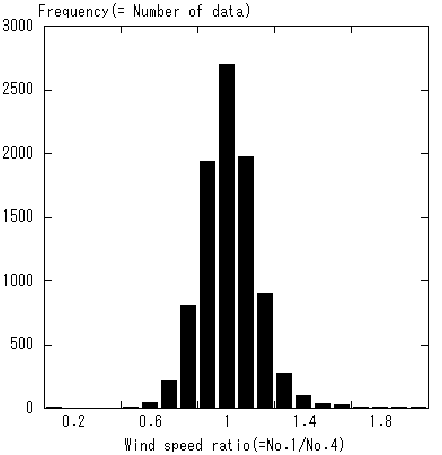
Figure 14. Observed time-series of the ratio of the hub-height wind speed at WT #1 to that at WT #4, only for times of northerly wind, February 2003.